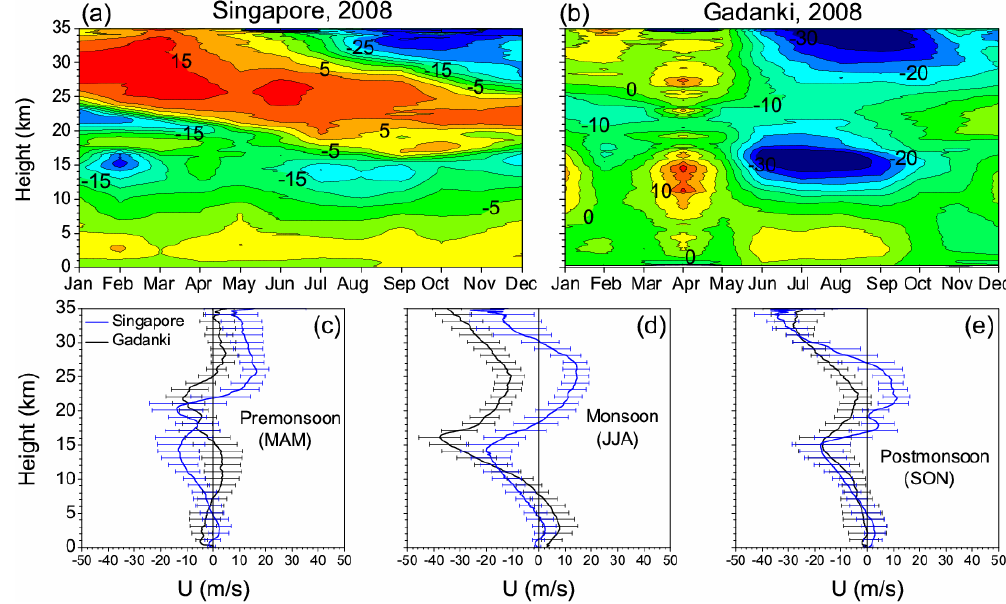
Fig. 4. Time-height section of zonal wind (m s -1 ) observed during January-December 2008 at (a) Singapore, (b) Gadanki. Mean profiles observed while averaging during (c) pre-monsoon, (d) monsoon, and (e) post-monsoon seasons for both Gadanki and Singapore.